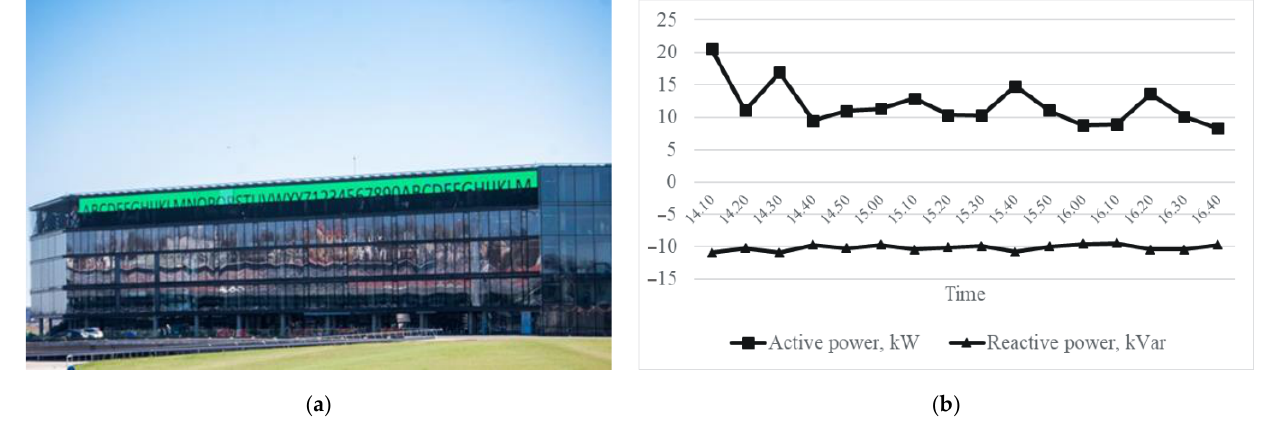
Figure 1. The 32 kW LED wall display at a sports arena: ( a ) Installation of the wall display; ( b ) Time diagram of active and reactive power at the point of LED wall display connection to 0.4 kV power distribution line.